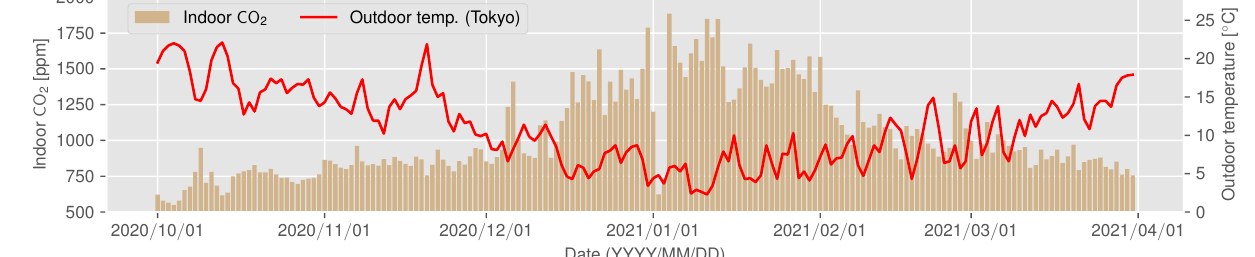
Figure 10. The changes in indoor CO 2 concentration (vertical bars) and outdoor temperature (red line) at ID